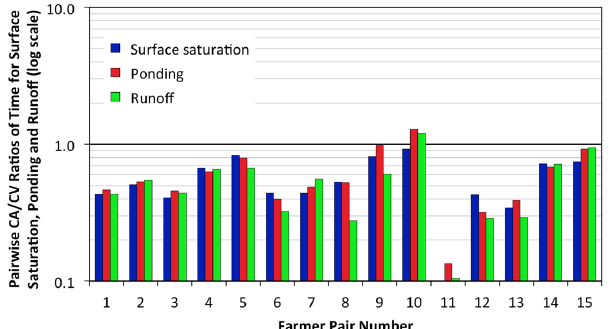
Figure 1. Pairwise ratios of time for initial surface saturation, ponding, and runoff for conservation and conventionally tilled fields.